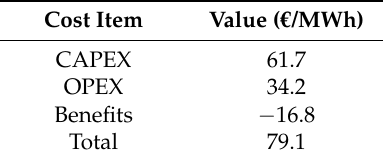
Table 6. LCOHC of the DHC